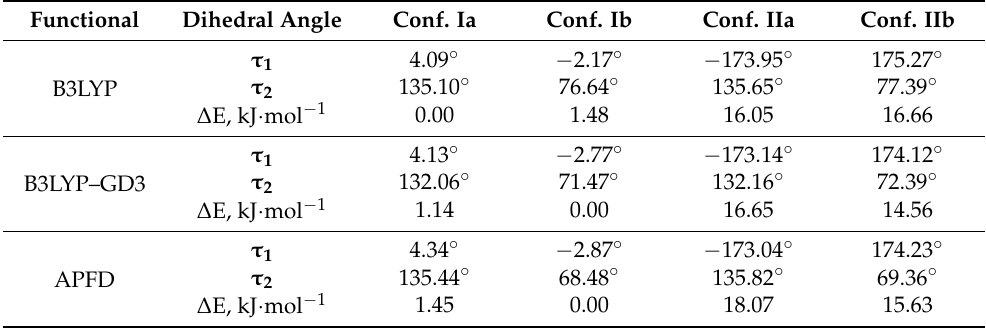
Figure 2. Schematic representation of the MA molecule with atoms forming dihedral angles τ 1 (C4–C3–C10–O11) and τ 2 (C4–N15–C17–C19). These atoms are shown in green color. Table 2. Values of the dihedral angles τ 1 and τ 2 of the four most stable conformers that were obtained by QCC applying three functionals.